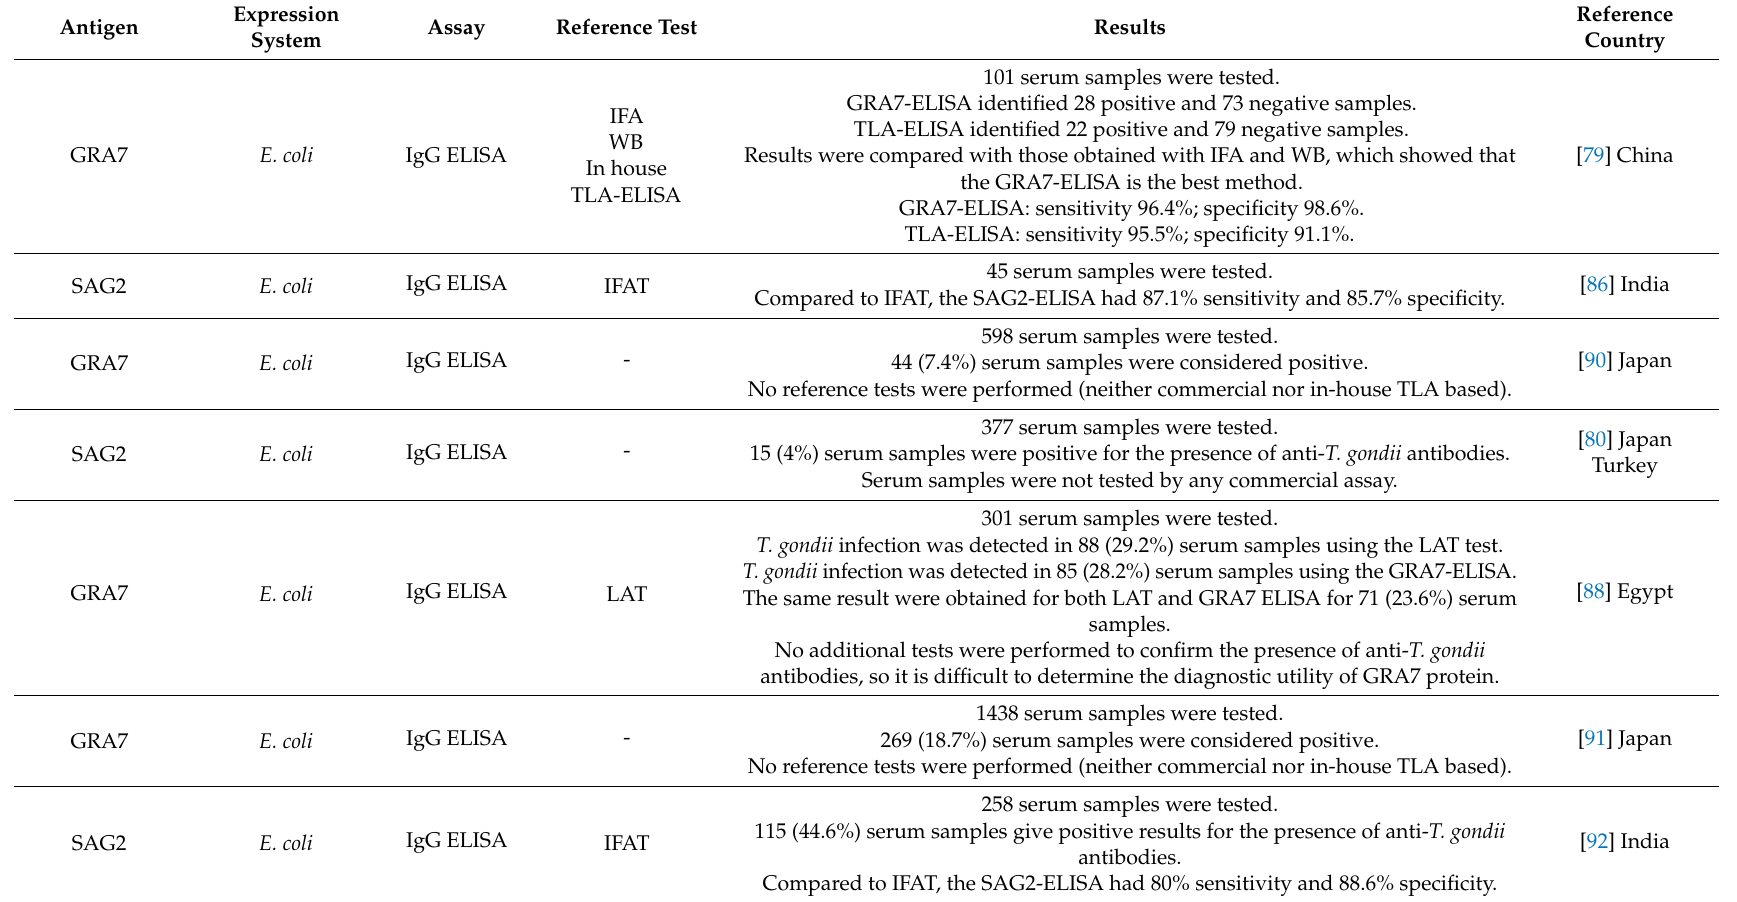
Table 5. Recombinant antigens used in detection of anti -T. gondii antibodies in bovine serum